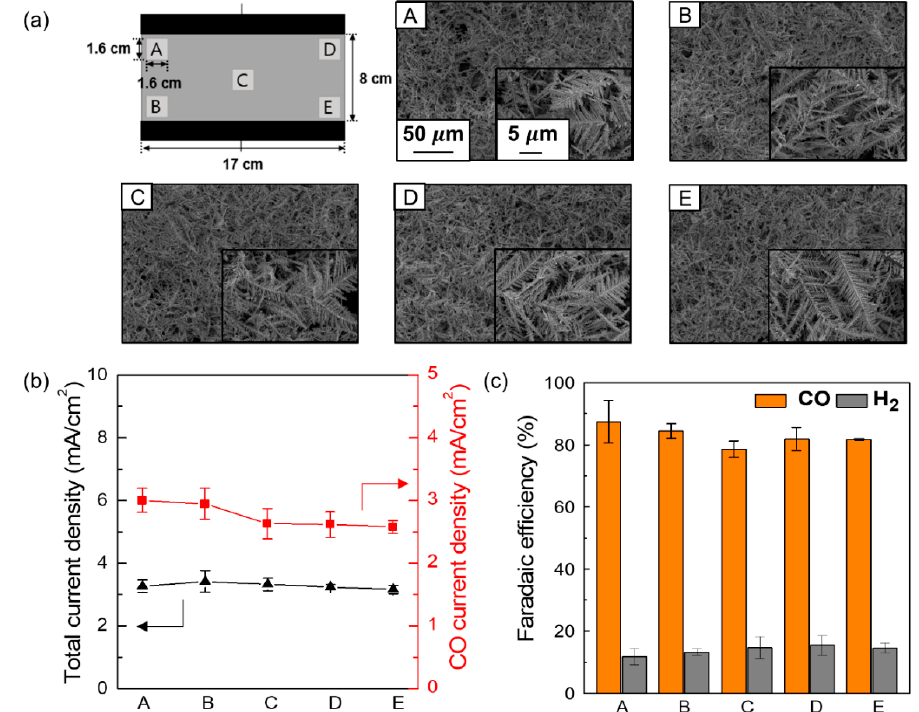
Figure 9. ( a ) FE-SEM images of the fabricated 136 cm 2 Ag GDE according to the position on the electrode. Ag deposition was performed at 0.83 mA / cm 2 for 50 min with a working-counter electrode distance of 4 cm. ( b ) Total electrolysis current density and CO production current density of the 136 cm 2 Ag GDE according to the position and ( c ) the corresponding FE for CO and H 2 . The CO 2 reduction was performed at a constant voltage of − 1.5 V (vs. SCE) in a laboratory-made H-type cell. 0.5 M KHCO 3 was used for both the anolyte and the catholyte.